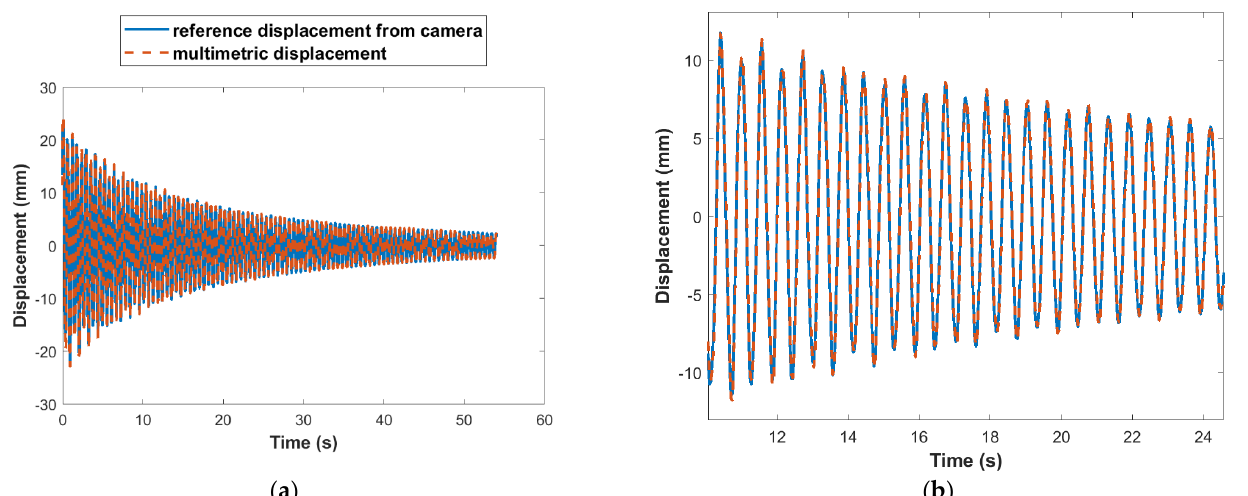
Figure 9. Comparison of estimated and reference first-story displacement. ( a ) Time domain comparison. ( b ) Time domain close-up view.